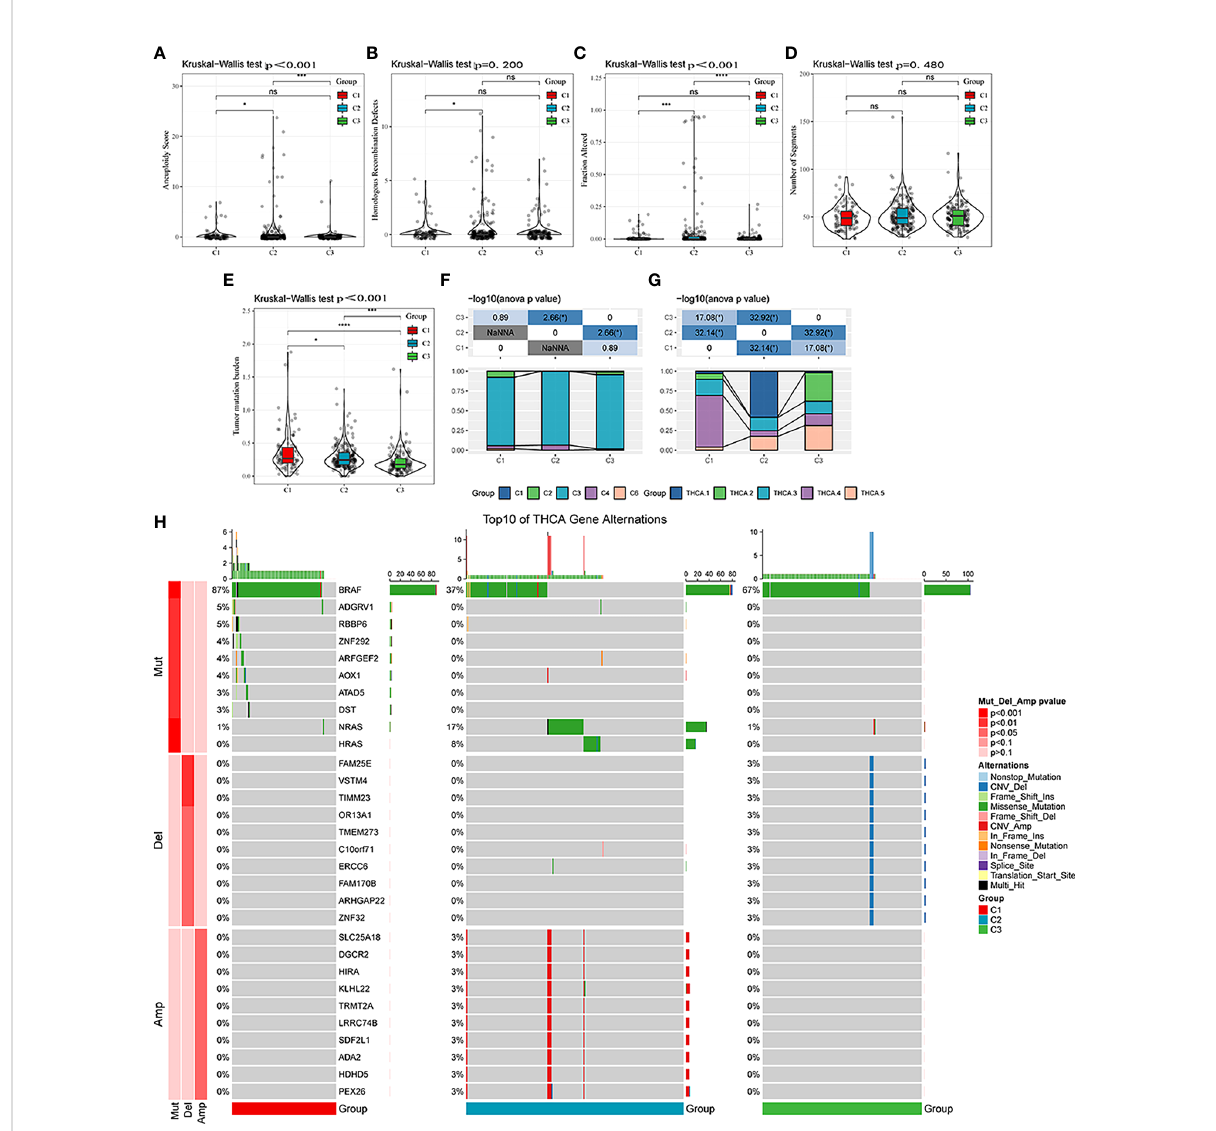
FIGURE 5 Mutational features of different molecular subtypes. (A – E) Comparison of aneuploidy score, homologous recombination defects, altered fraction, number of segments, and tumor mutation burden among different molecular subtypes. (F) Comparison of six molecular subtypes and three molecular subtypes. (G) Comparison of fi ve molecular subtypes and three molecular subtypes. (H) Somatic mutation and copy number variation analysis among the three molecular subtypes. ns, Not statistically signi fi cant; * p < 0.05; ** p < 0.01; *** p < 0.001; **** p <